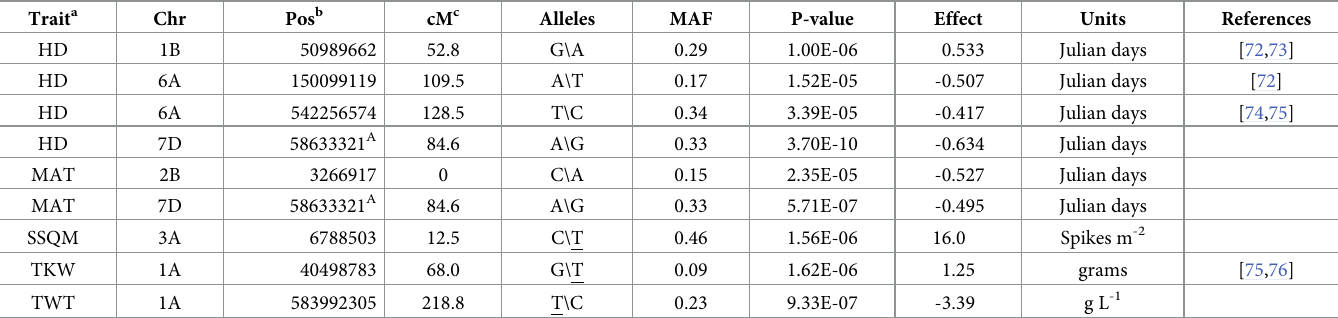
Table 3. Significant marker-trait associations identified by the GCTA leave-one-chromosome-out method. Trait